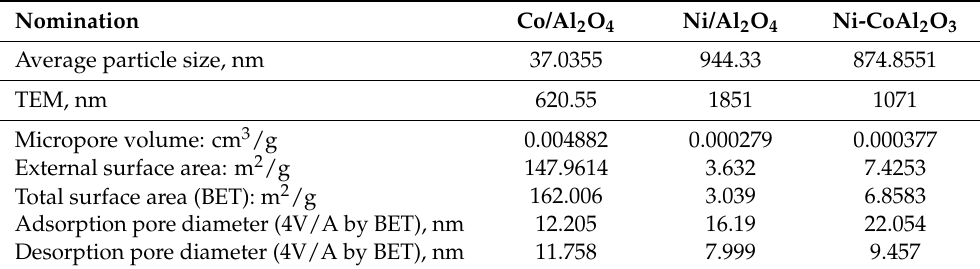
Table 5. Characteristics of mono- and bimetallic catalysts using the micrometry